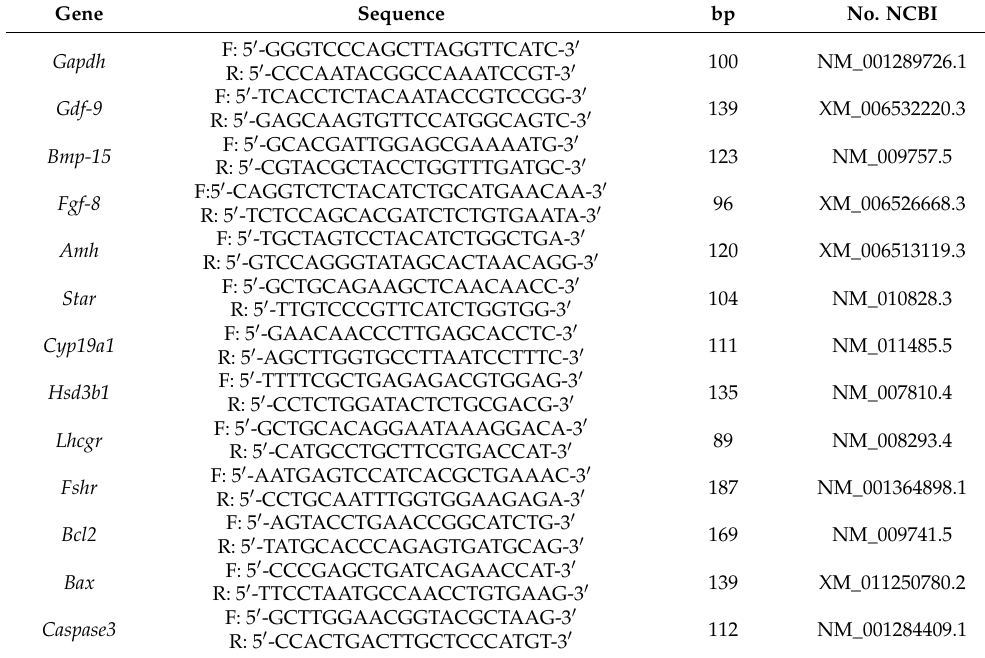
Table 1. RT-PCR primers of target genes. Note: 39 amplification cycles of 95 ◦ C for 10 s, 60 ◦ C for 20 s, and 72 ◦ C for 15 s. The efficiency of qPCR is between